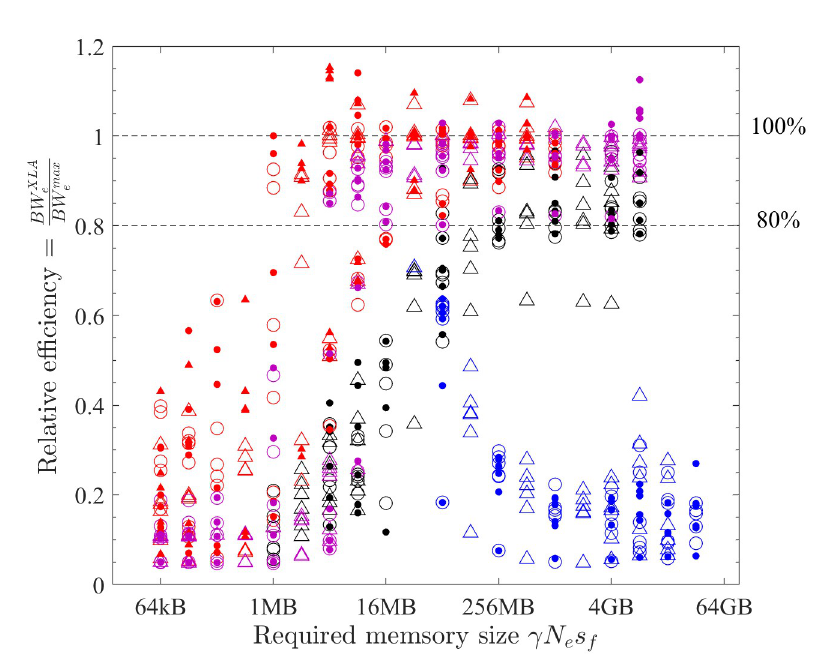
Fig 12. Relative efficiency of XLA for element-wise operations (hollow = vector operations; filled = matrix operations; circles = f64; triangles = f32; black = PC CPU; red = PC GPU; blue = HPC CPU; magenta = HPC